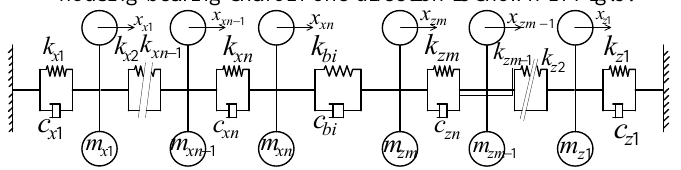
Fig.5. Dynamic model of housing-bearing-shaft